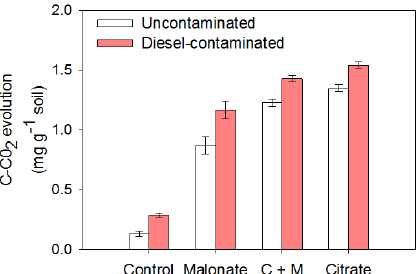
Figure 1. Cumulative CO 2 evolved over the 18-day incubation in diesel-contaminated and uncontaminated soils which received water (control) or 5µmolg − 1 soil of citrate, malonate, or cit- rate + malonate every 48h. Values are means ± SE ( n = 4). There was an effect of carboxylate addition ( P < 0.001) and diesel con- tamination ( P < 0.001) but no significant